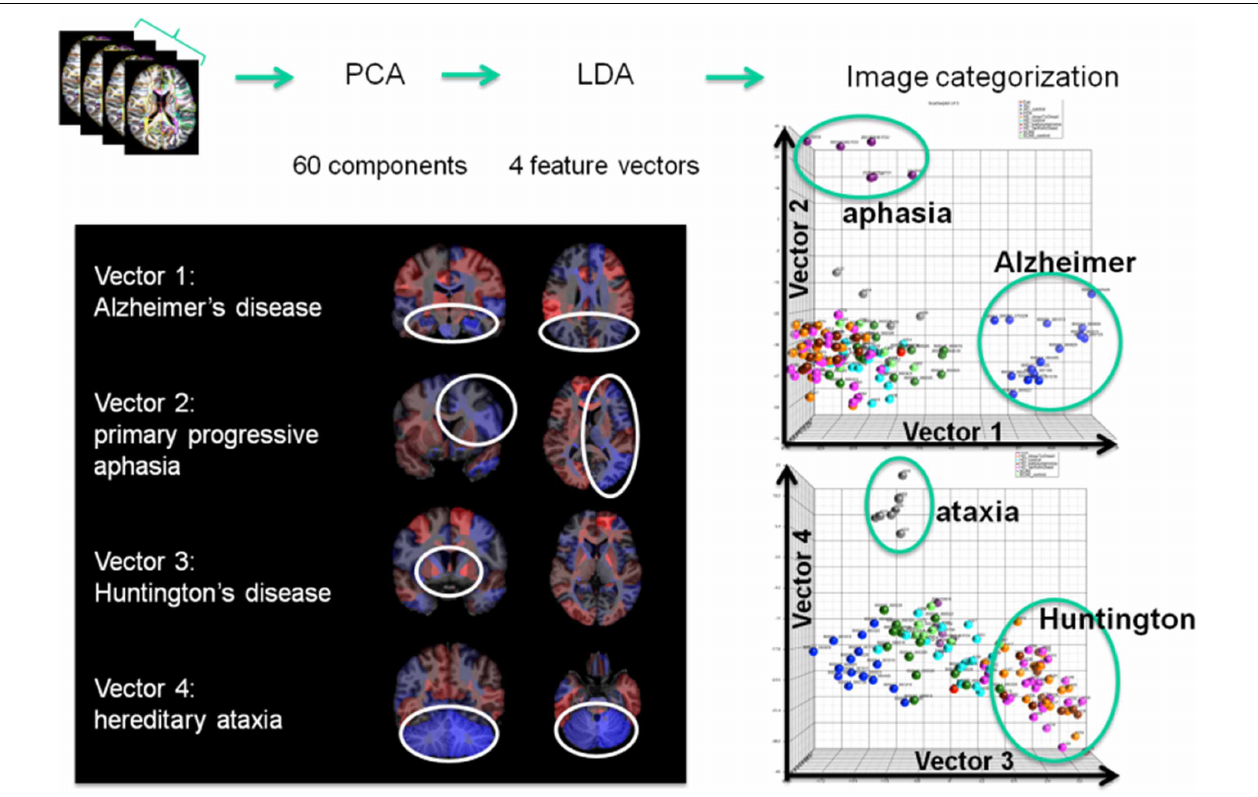
FIGURE 10 | Showing four clinically labeled disease categories of Alzheimer’s Disease, aphasia, Huntington’s, hereditary ataxia, and one control group upon which the anatomical features were learned including 60PCA dimensions followed by supervised LDA